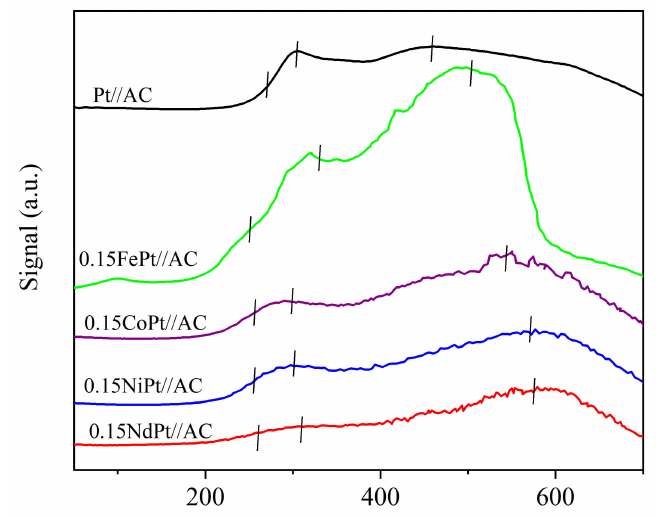
Figure 6. H 2 temperature-programmed reduction profiles of the